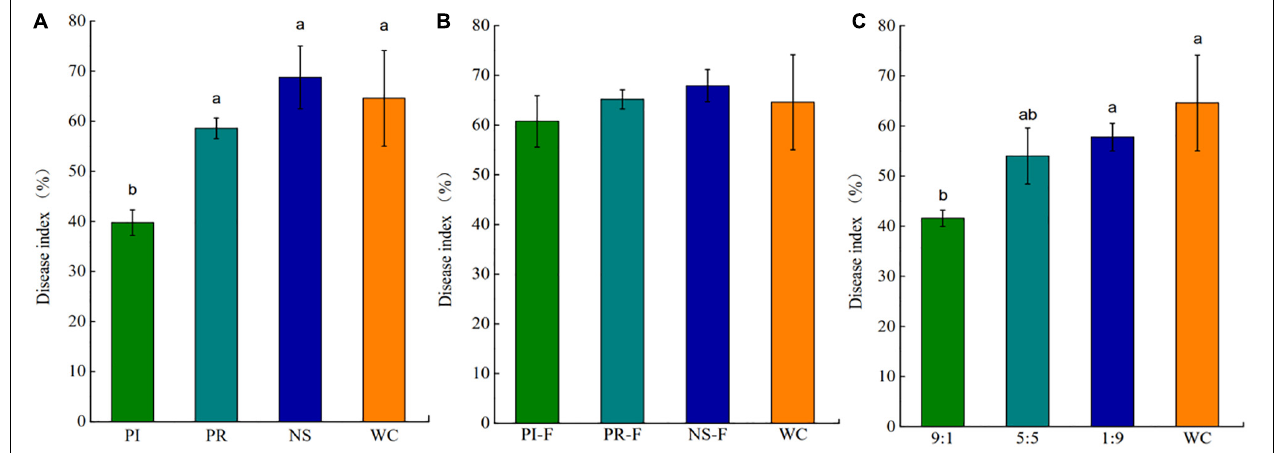
FIGURE 6 | Disease index (DI) of Ps. camelliae-sinensis- challenged tea seedlings growing on sterilized soil inoculated with slurries of pathogen-repressed (PR), pathogen-induced (PI), natural soil (NS), and water control (WC) (A) , filter-sterilized slurries of PR, PI, NC, and WC (B) , and PR and PI mixed at a ratio of 1:9, 5:5, or 9:1, and WC (v/v) (C) . Data are means ± SEs of six replicates. a, b, and c indicate significant differences ( p <